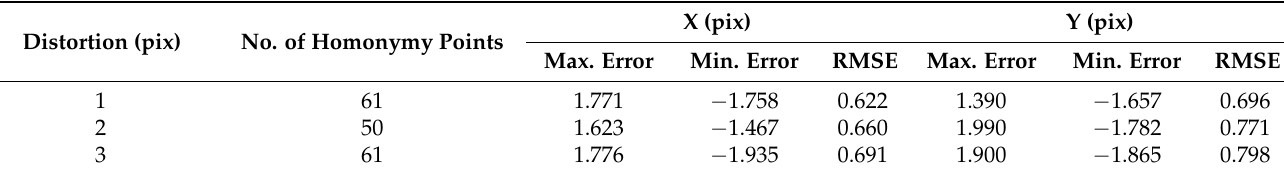
Table 14. Relative orientation residual of EA-unstable-3 (left-middle image)